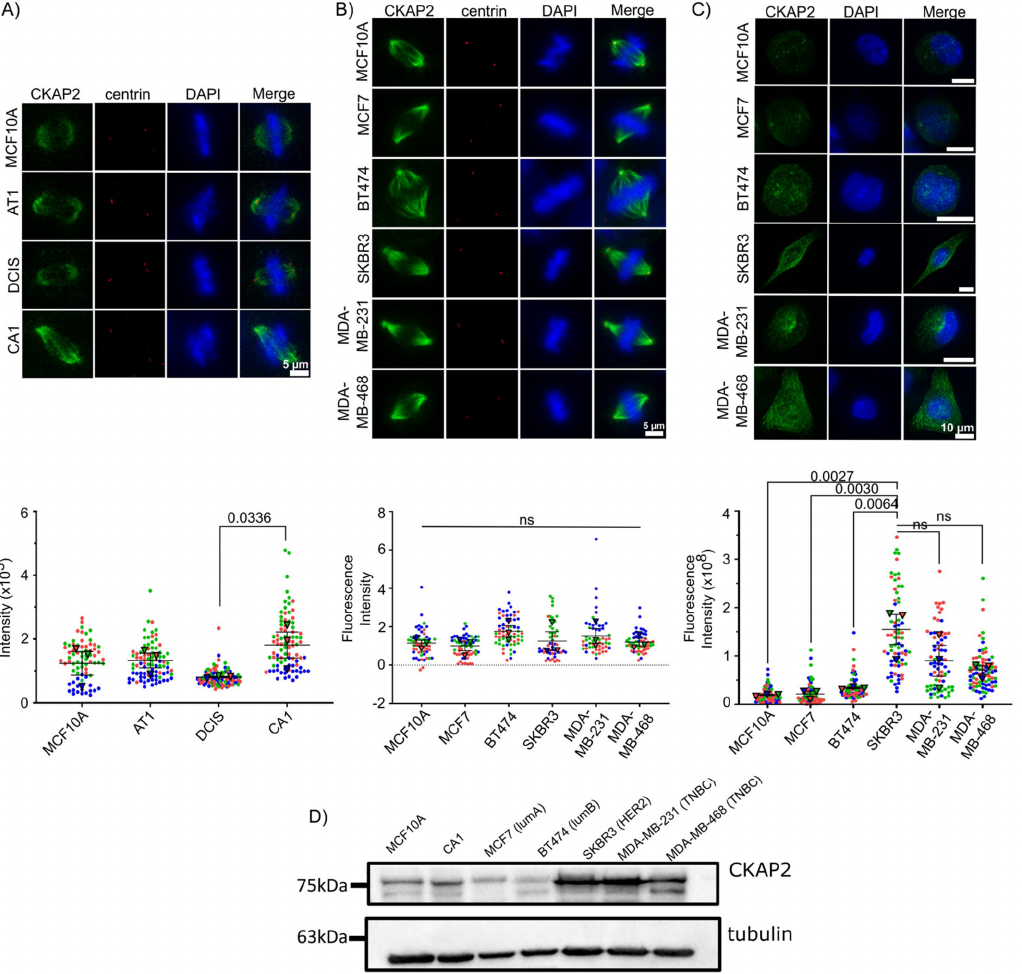
Figure 7. CKAP2 expression in MCF10A series and other invasive ductal carcinoma (IDC) cell lines (MCF7, BT474, SKBR3, MDA-MB-231, MDA-MB-468) by immunofluorescence. ( A – C ) Cells were stained with CKAP2 (green), centrin (red), and Hoechst (blue). The CKAP2 immunofluorescence intensity was measured in ≥ 60 cells per cell line. ( A ) Representative images of mitotic cells from MCF10A series (MCF10A, AT1, DCIS, and CA1). Superplots show the quantification of CKAP2 intensity. ( B ) Representative images of mitotic cells from other IDC cell lines (MCF7, BT474, SKBR3, MDA-MB-231, MDA-MB-468). Superplots show the quantification of CKAP2 intensity. ( C ) Representative images of interphasic cells from other IDC cell lines (MCF7, BT474, SKBR3, MDA- MB-231, MDA-MB-468). Superplots show the quantification of CKAP2 intensity. ( D ) Immunoblot showing CKAP2 protein levels in MCF10A and CA1 and other IDC cell lines (MCF7, BT474, SKBR3, MDA-MB-231, MDA-MB-468). Tubulin: loading control. LumA: luminal A, lumB: luminal B; HER2: human epidermal growth factor receptor 2 positive; TNBC: triple negative breast cancer.